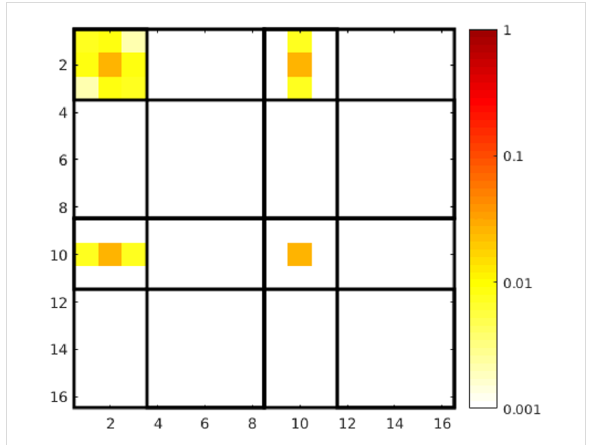
Figure 10: T-matrix entries of the right handed helix, calculated with the presented method at 1.5 THz with 10 extra illuminations. See Figure 4 for a description of the